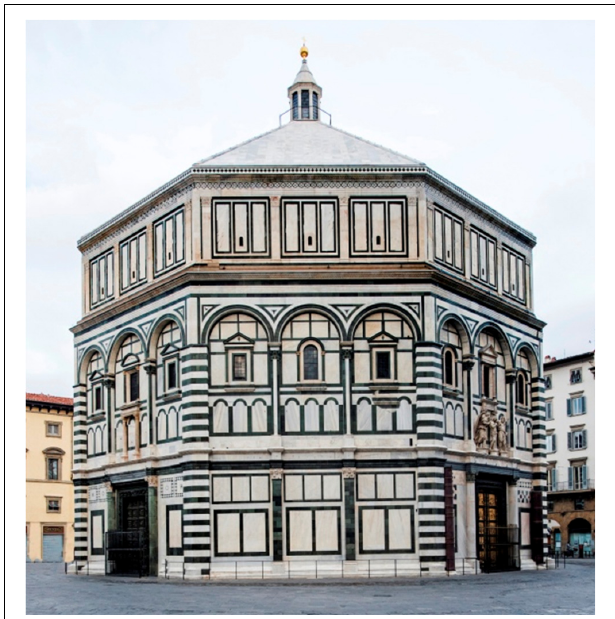
FIGURE 1 | External view of the Baptistery of San